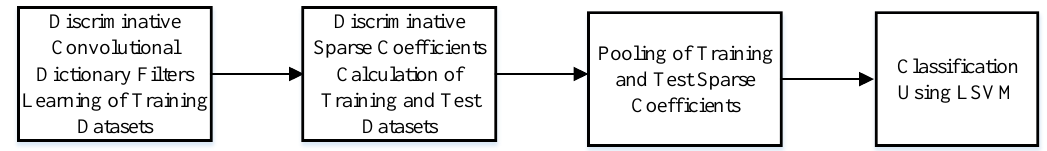
Figure 1. Block diagram of the proposed ECG classification system.